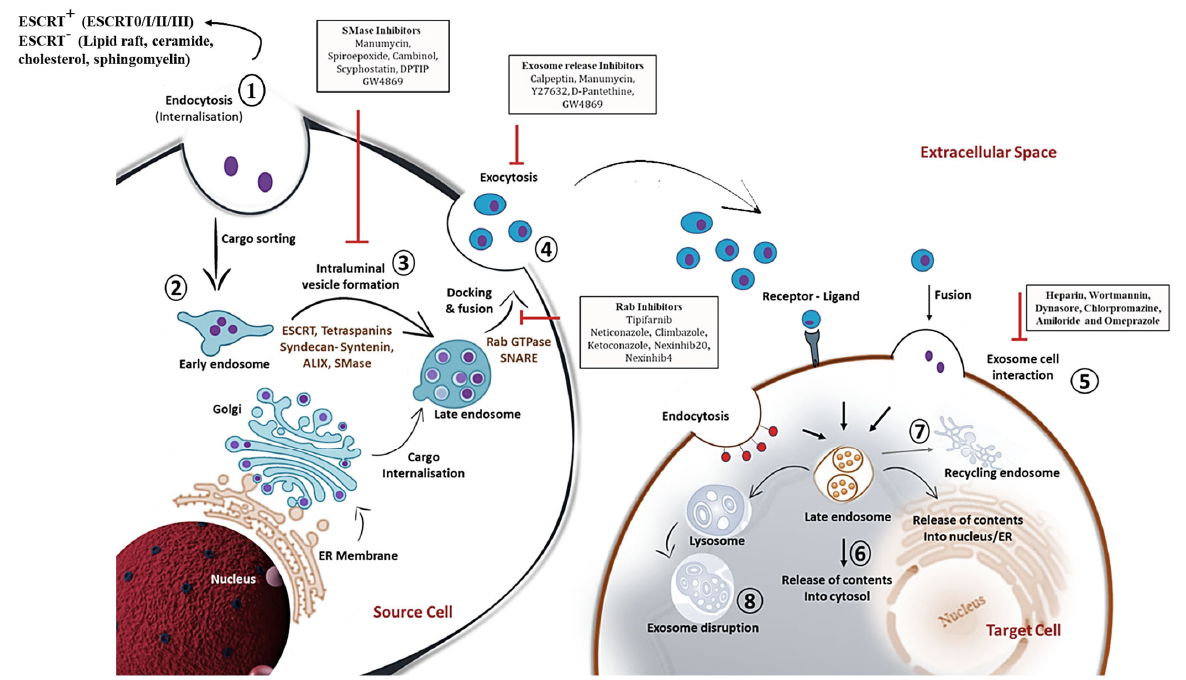
Figure 1. Detailed schematic overview of exosome biogenesis and inhibitors that block the release of exosomes within the endosomal system. The formation of exosomes involves the inward budding and fusion of the limiting membrane of endocytic vesicles that engender intraluminal vesicles (ILVs). The maturation process of ILVs can be through endosomal complexes required for transport (ESCRT)-dependent and -independent mechanisms that process cargo sorting and formation of multivesicular bodies (MVBs). Components of MVBs can then be integrated into the membranes for release into the extracellular space or may be guided for lysosomal degradation. Exosomal contents released into the extracellular space can then be internalized by the target cell via membrane fusion, ligand-receptor conformation or endocytosis mechanism. This illustration further comprehends various chemical inhibitors, including SMase inhibitors, exosome release inhibitors and Rab inhibitors (depicted in black rectangular boxes) that prevent exosome biogenesis and secretion within the endosomal compartment. The sequential steps on exosome biogenesis follows: 1. Exosome formation; 2. Cargo sorting; 3. MVBs formation; 4. Exosome release; 5. Exosome-target cell interaction; 6. Cargo release into cytosol of target cells; 7. MVBs endosome recycling; and 8. Lysosome degradation of exosomes. Abbreviations: Rab; Ras associated binding protein, SNARE; SNAP